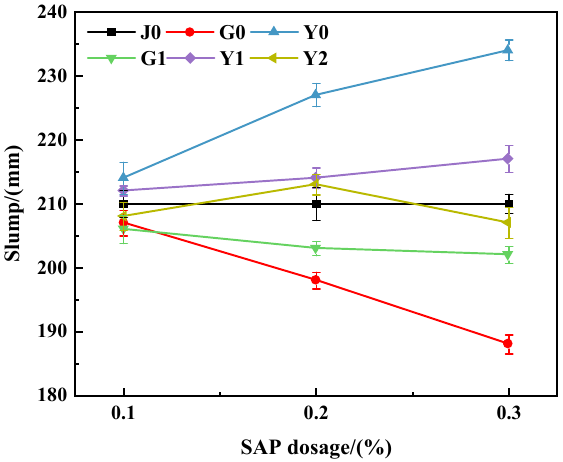
Figure 1. Concrete slump with different SAP contents.